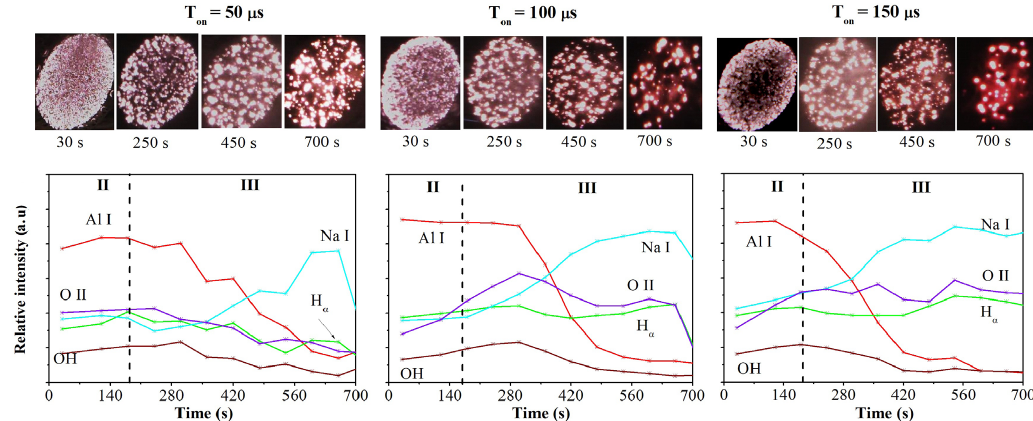
Figure 2. (a) Operating voltage and time response for the three T spectrum for the three T current pulse. on